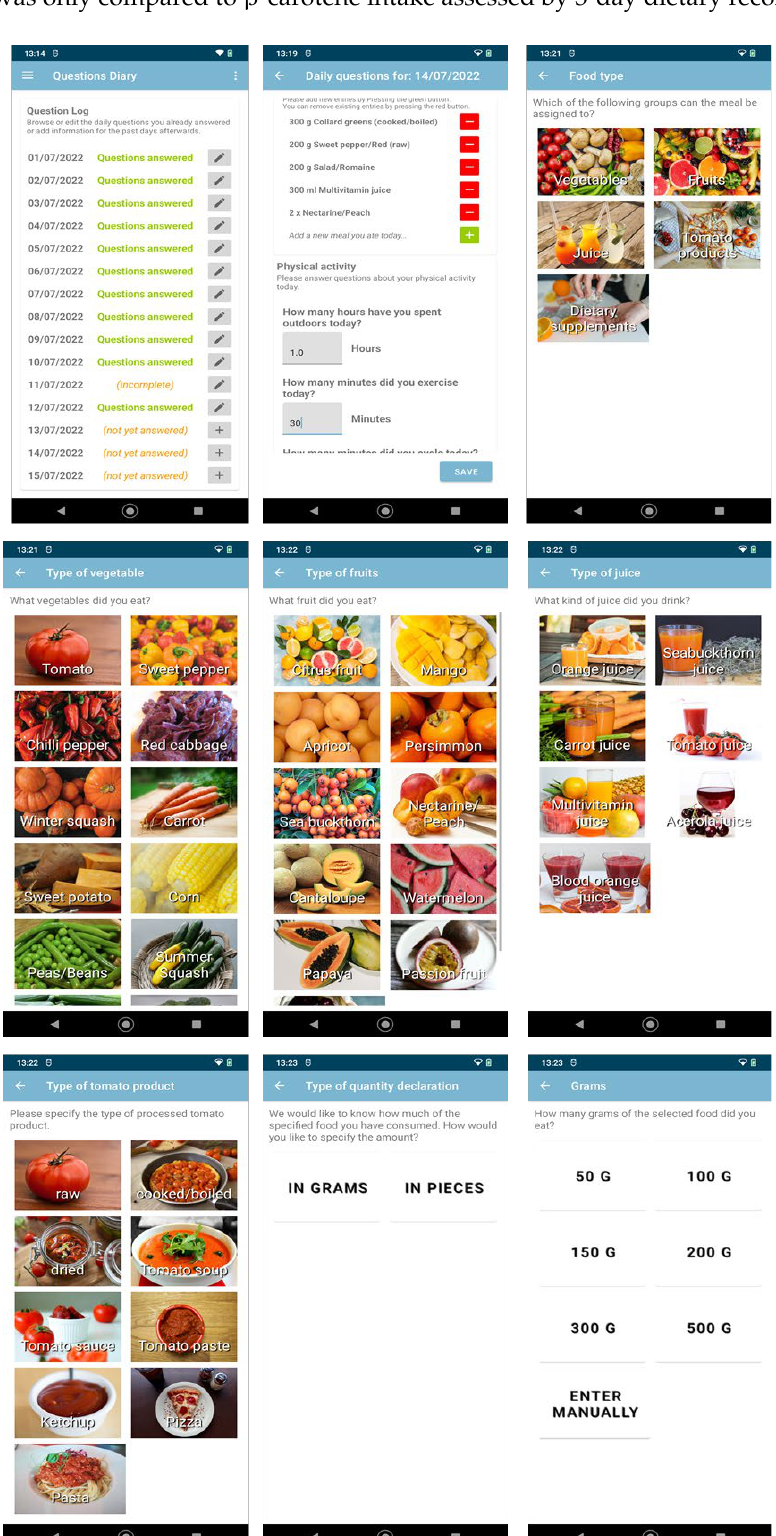
Figure 1. Study app used for daily tracking of carotenoid-rich food items.